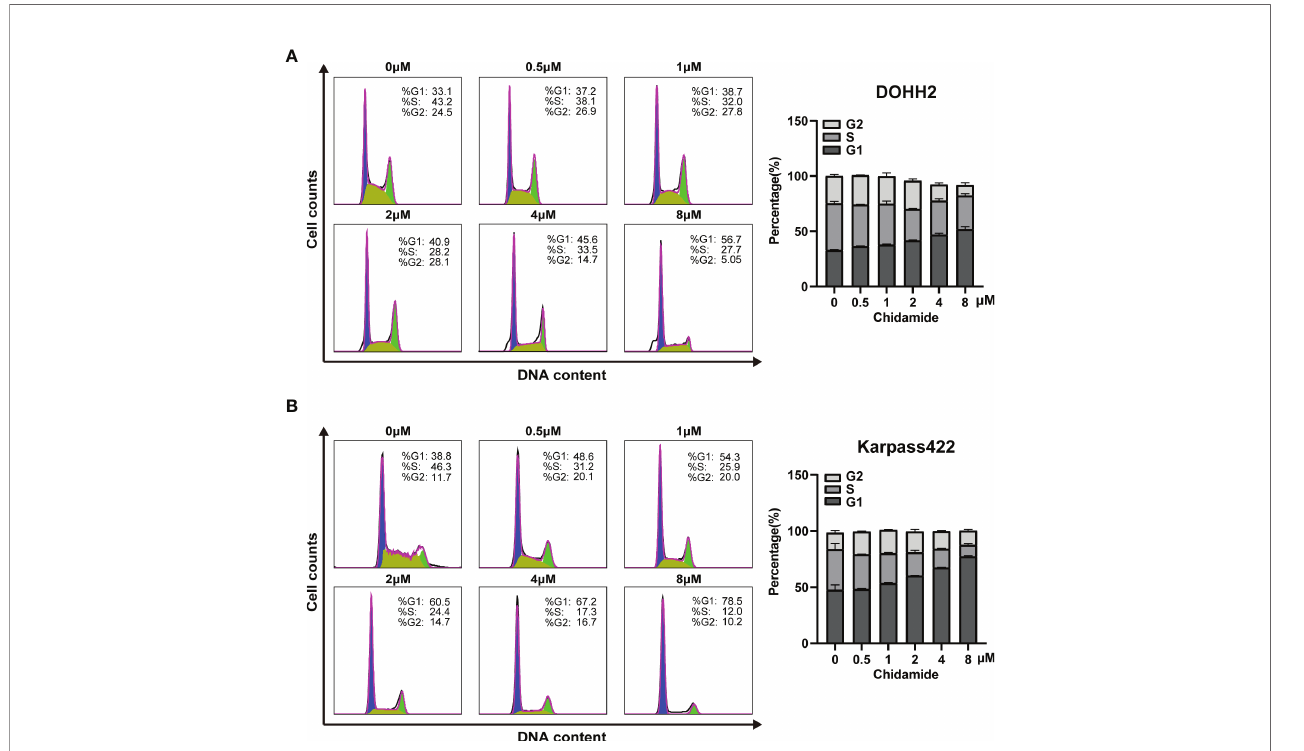
FIGURE 4 | Chidamide induces FL cell cycle arrest in the G0/G1 phase. DOHH2 and Karpas422 cells were treated with chidamide for 24 h at the indicated concentrations, and cell cycle distribution in (A) DOHH2 and (B) Karpas422 cells was analyzed by fl ow cytometry. Representative fl ow cytograms are shown in the right